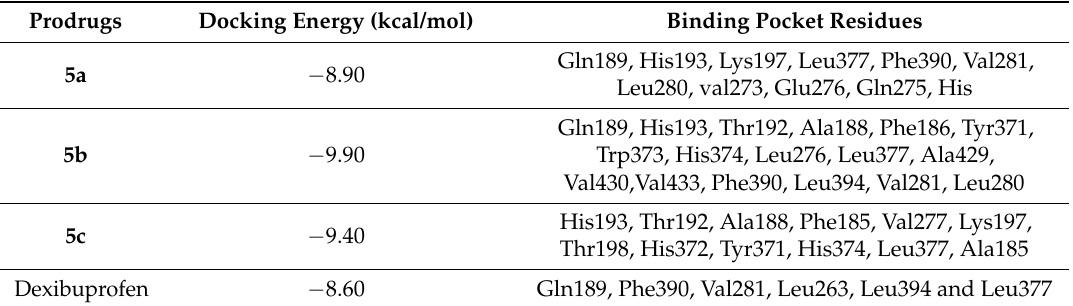
Table 6. Docking results of pro-drug compounds using